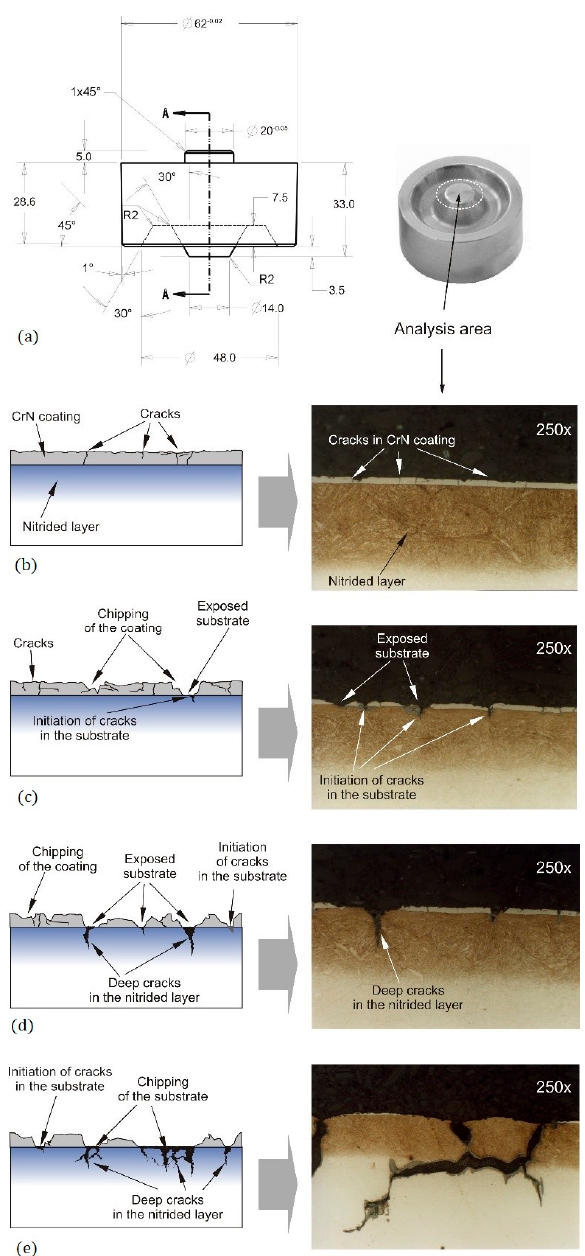
Figure 7. The wear mechanism scheme for the subsequent stages of “NL + CrN coating” hybrid layer during the forging process. Reprinted from permission from [15]. Copyright 2007 the Łukasiewicz Research Network—Institute for Sustainable Technology. Through the destruction of the chromium nitride coating and substrate exposure the effectiveness of the protective barrier, i.e., the CrN coating is reduced. What is more, ther- mal processes in the substrate resulting from tempering are intensified, which leads to the reduction of hardness and plastic deformation, and, in the end effect, to changes in the geometry of forging and increased roughness of its surface. These defects are the direct reason why the die no longer fulfills the accepted quality criteria and is considered to be